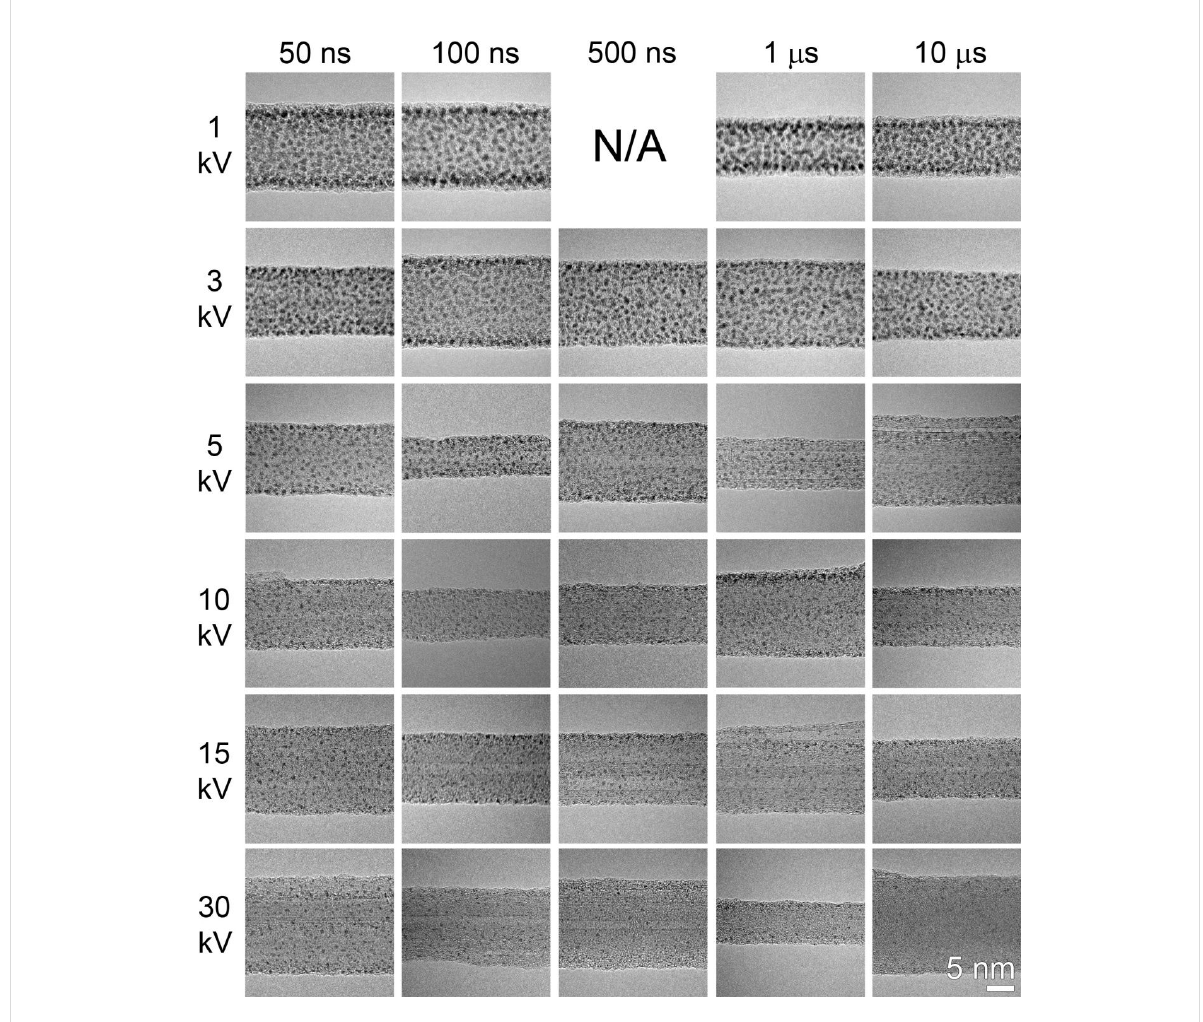
Figure 6: HRTEM images showing Pt nanoclusters deposited on CNTs by using different electron-beam settings. Beam energy is different as indi- cated in each row, whereas the beam dwell time is different as indicated in each column. The particular beam setting for the corresponding results are listed in Supporting Information File 2. For each beam setting, dwell times of 50 ns, 100 ns, 1 μ s, 10 μ s and 100 μ s are applied for